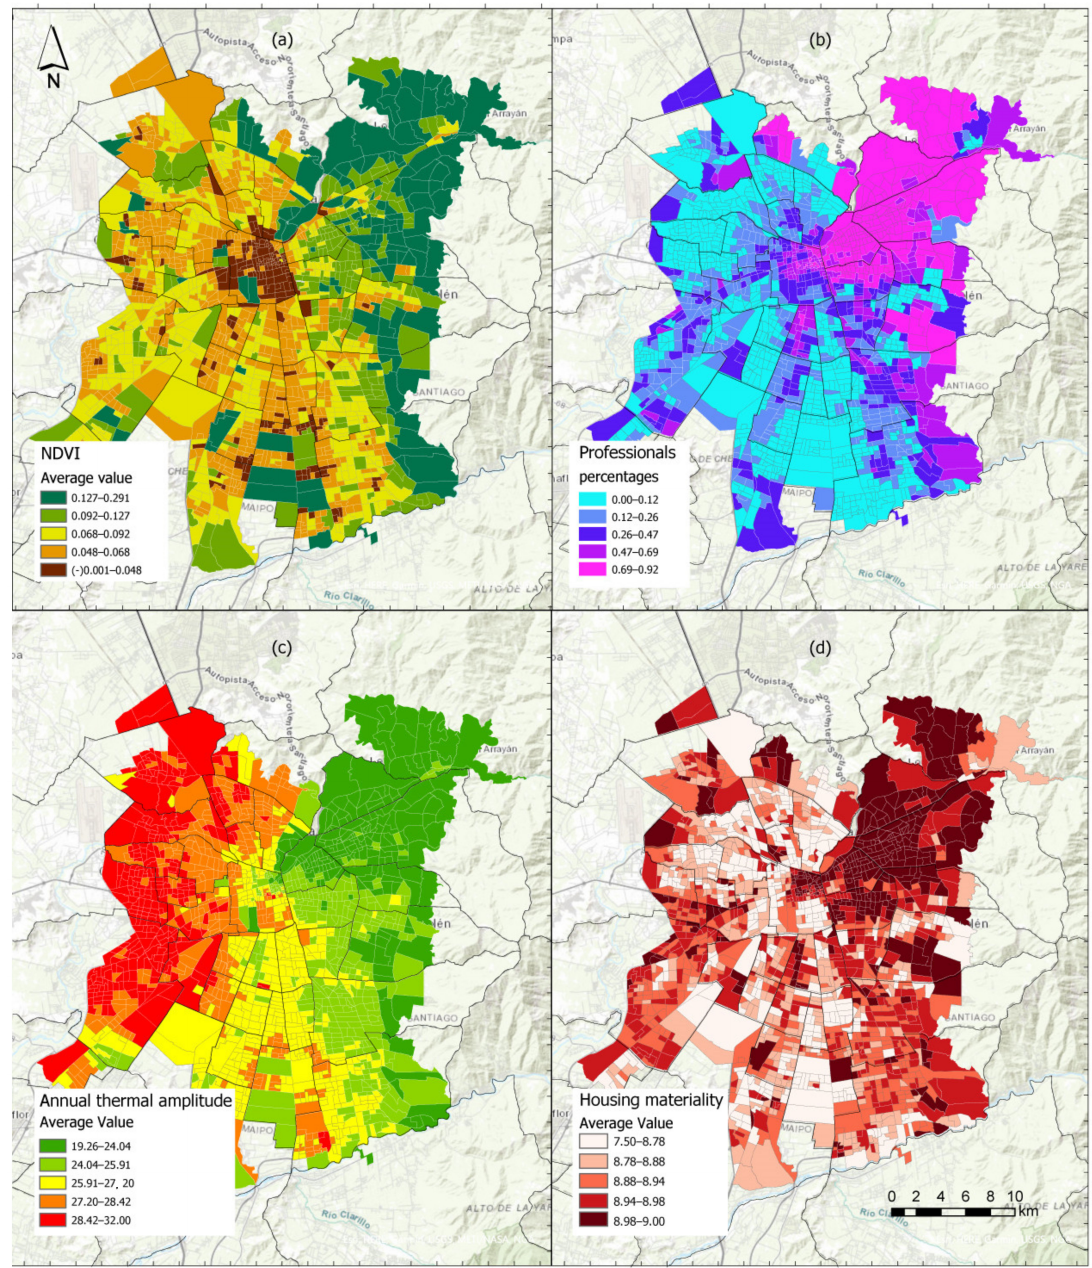
Figure 5. Description of the independent variables in the selected model: ( a ) 2017 NDVI; ( b ) the percentage of professionals; ( c ) 2017 annual thermal amplitude; ( d ) housing material quality